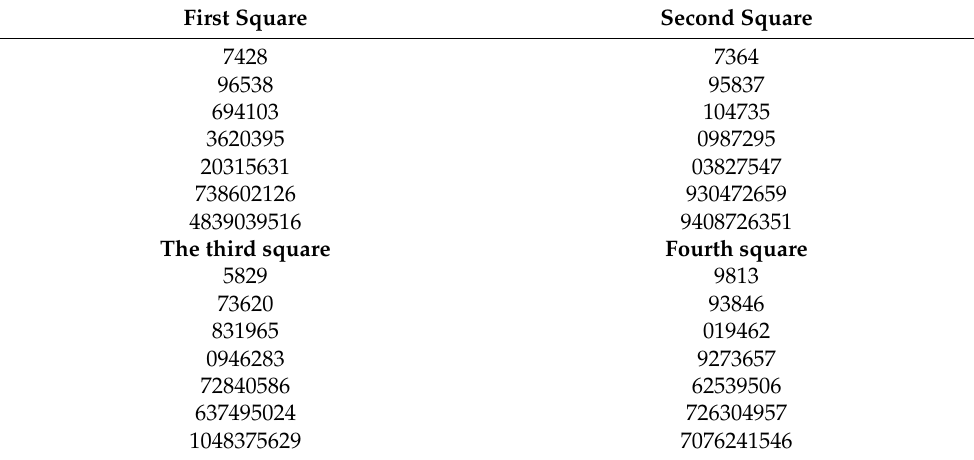
Table 2. Material for determining short-term memory. First